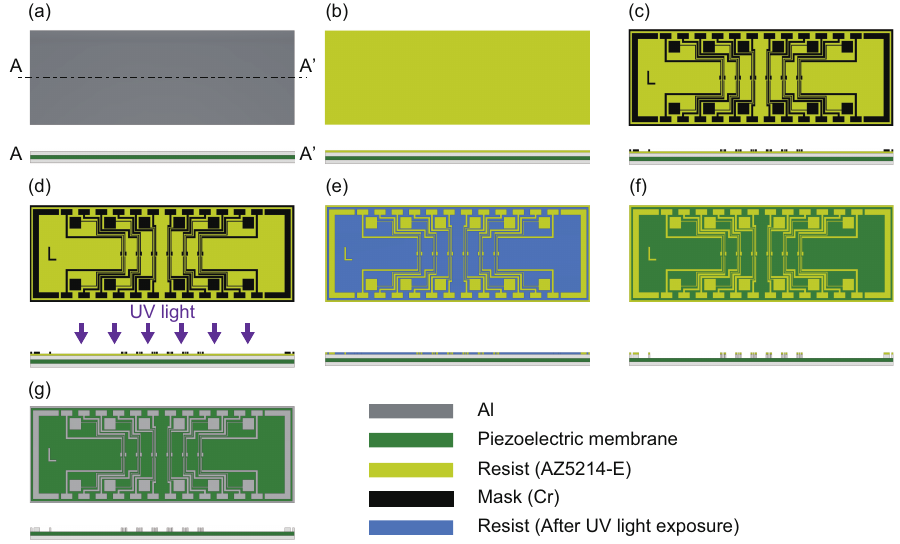
Figure A1. Fabrication process of the PVDF membrane with patterned electrodes. ( a ) Al-deposited piezoelectric membrane; ( b ) Spincoating of photoresist AZ5214-E; ( c ) Covering the photomask; ( d ) Exposure to ultraviolet light; ( e ) Removing the photomask; ( f ) Development and etching; ( g ) Lifting